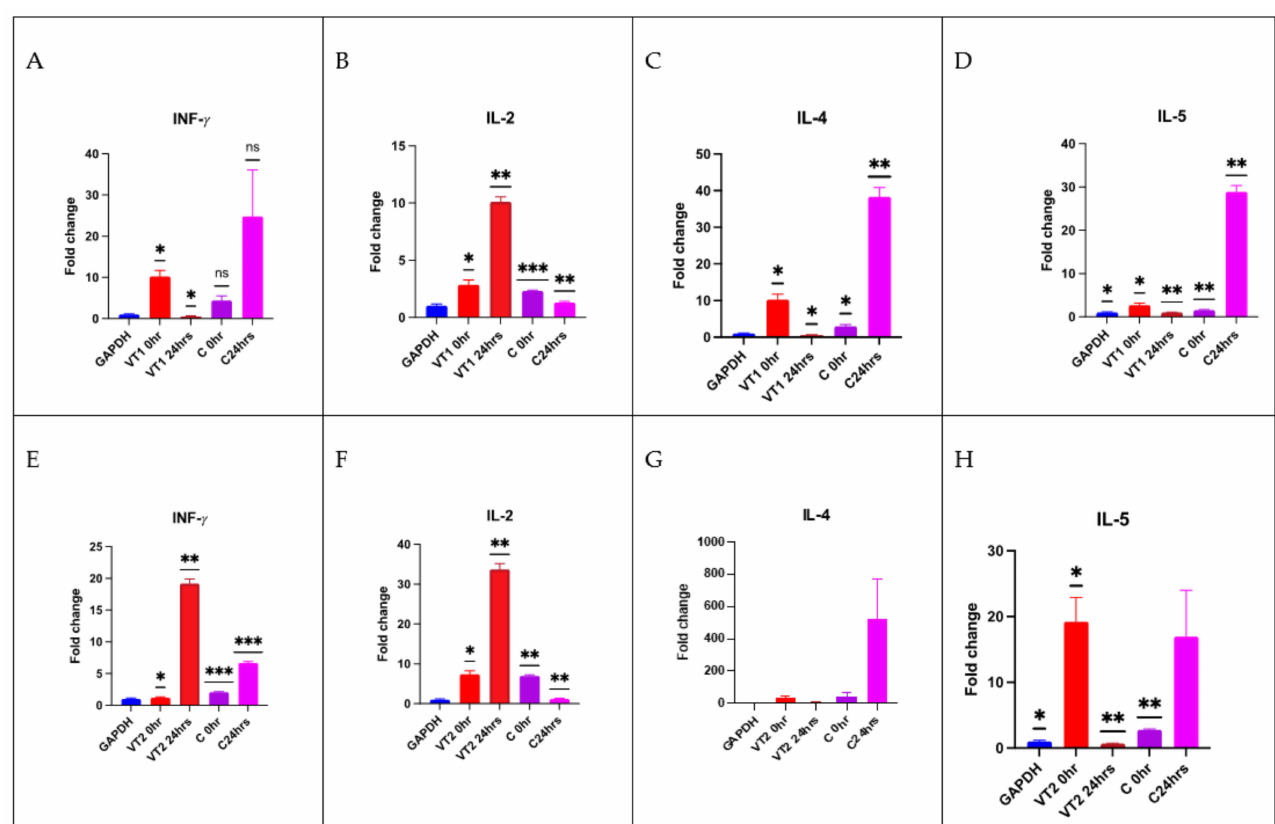
Figure 10. ( A – H ) Relative fold changes of INF- γ ( A , E ), IL-2 ( B , F ), IL-4 ( C , G ), and IL-5 ( D , H ) genes in different time intervals in VT1 (50 µ g antigen/animal) and VT2 (100 µ g antigen/animal) and control group of rabbits. Significant at * p < 0.05; ** p < 0.01; *** p <